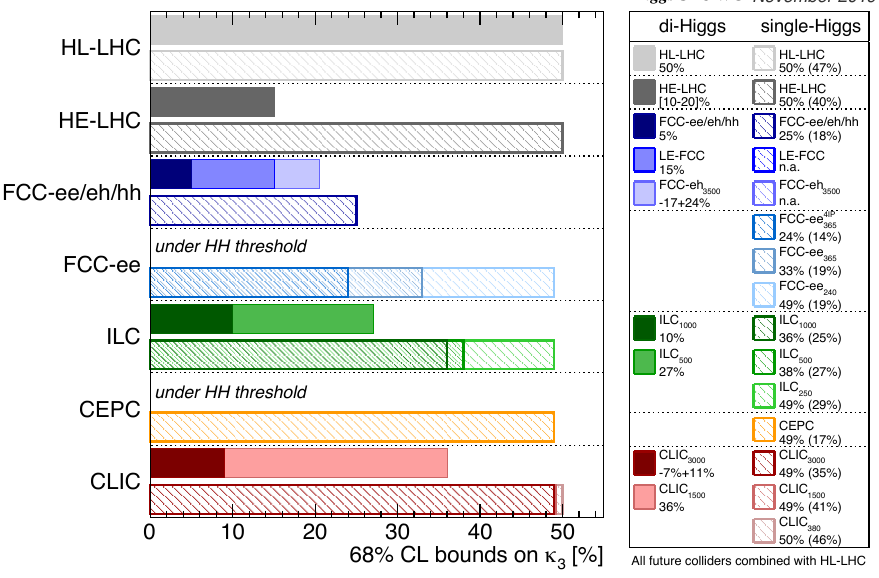
Figure 11 . Sensitivity at 68% probability on the Higgs cubic self-coupling at the various FCs. All values reported correspond to a simpli(cid:12)ed combination of the considered collider with HL- LHC. Only numbers for Method (1), i.e. \di-H excl.", corresponding to the results given by